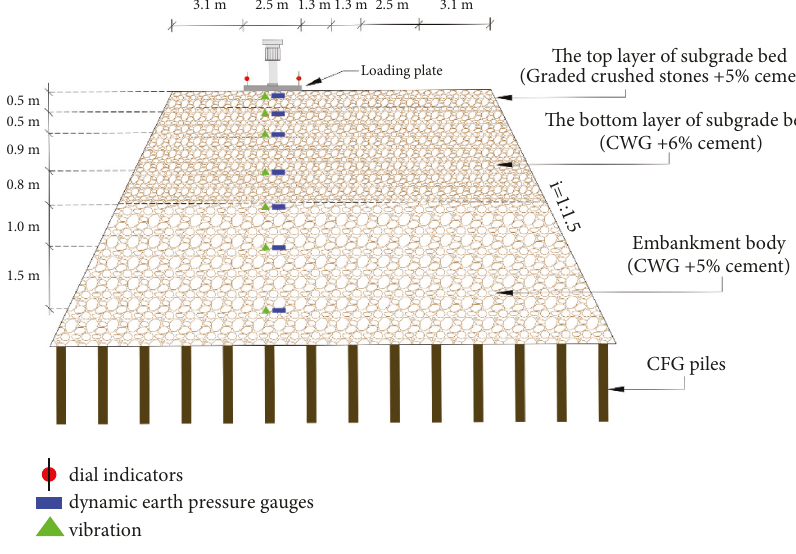
Figure 4: Layout of field instrumentation.